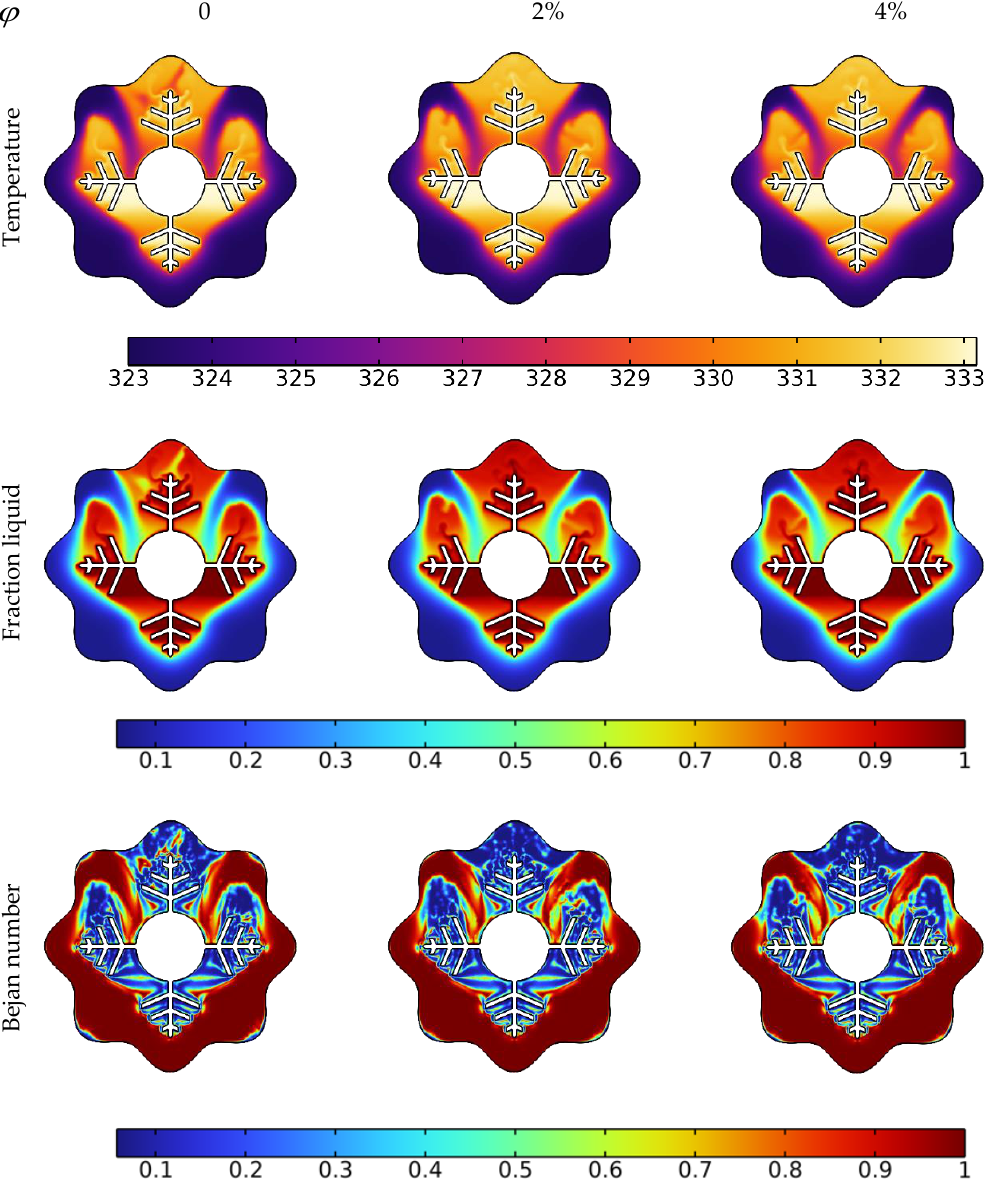
Figure 5. Impact of Cu nanoparticle concentration on temperature, liquid fraction, and Bejan number during the PCM melting process after 10 min.